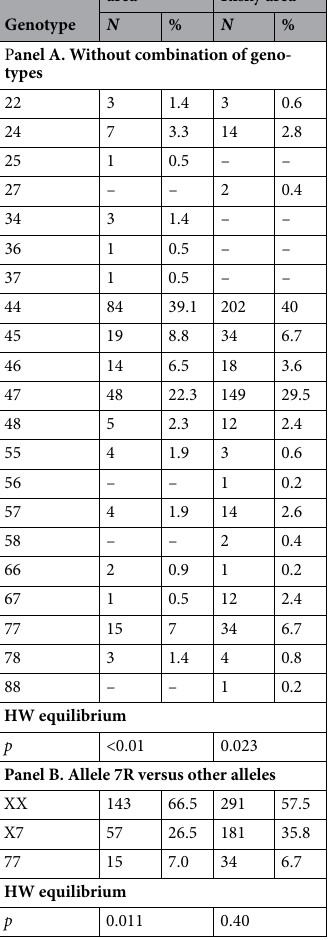
Table 1. Genotypic composition at the DRD4 locus of populations from the Saint-Louis region in the non- risky and risky areas. The p -value ( p ) corresponds to the HW probability exact test. Genotype ij refers to the DRD4 genotype iR/jR. For Panel B , all alleles not 7R are combined in the X